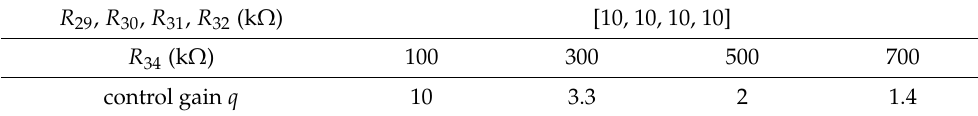
Figure 13. Synchronous control circuit. Table 3. Synchronous control gain.